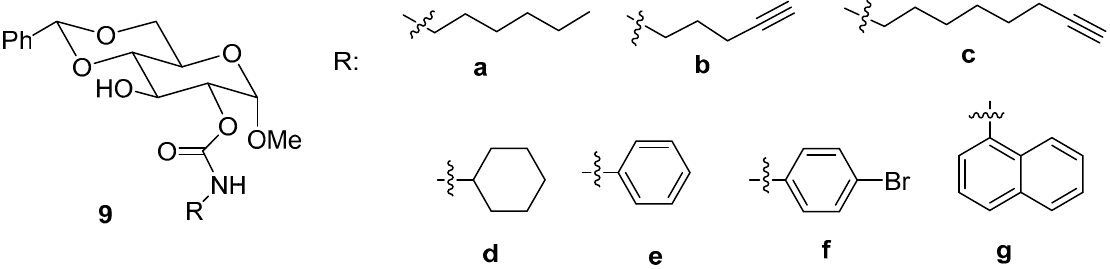
Figure 3. Oxygen linked carbamate derivatives of methyl-a-D-glucopyranoside [34].